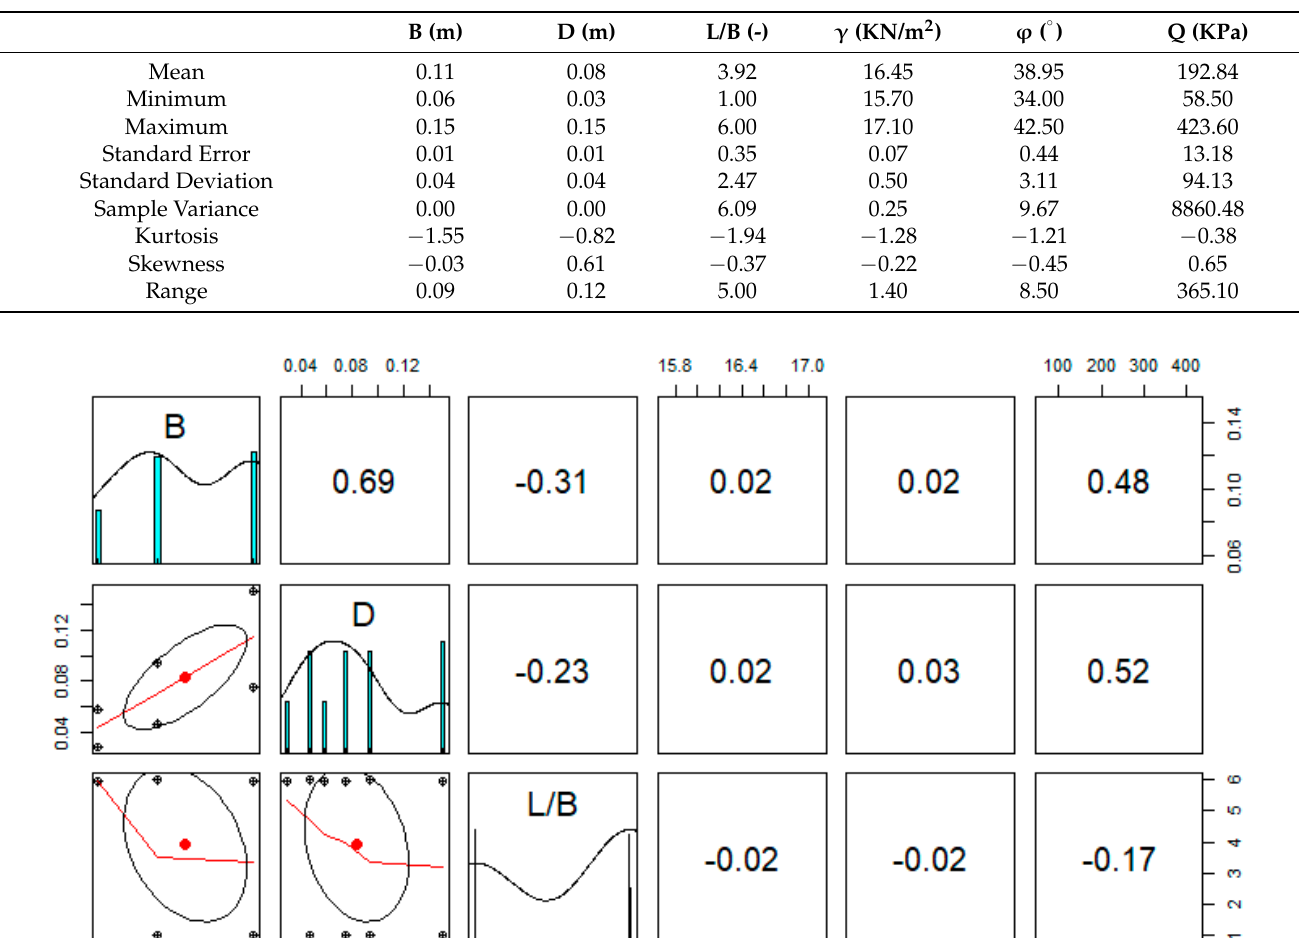
Table 1. Descriptive statistics of the field data.